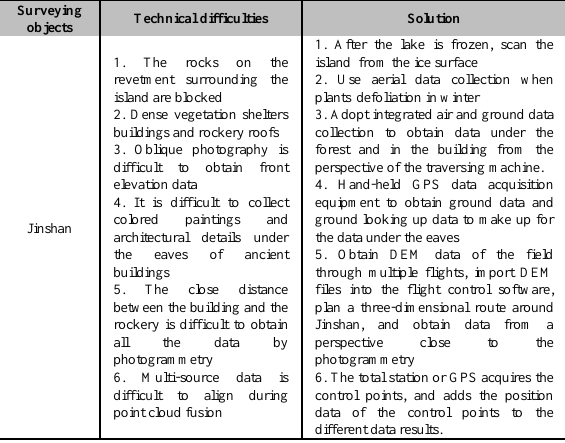
Table 3 . Technical difficulties and solutions of rockery